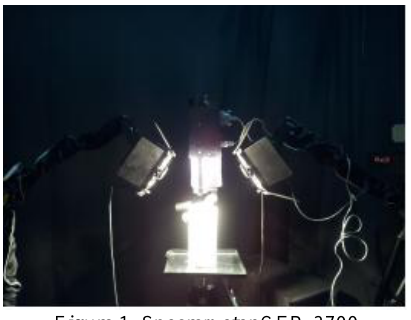
Figure 1. Specrometer GER-3700